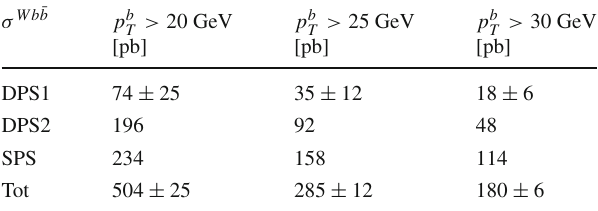
Table 2 Predictions for Wb ¯ b DPS and SPS cross sections in pA col- lisions in fiducial phase space, for different cuts on jets transverse momenta. These numbers refer to charged summed W cross sections accounting for the W boson decaying into muons as well as electrons. The quoted error is entirely due to the propagation of σ ef f uncertainty